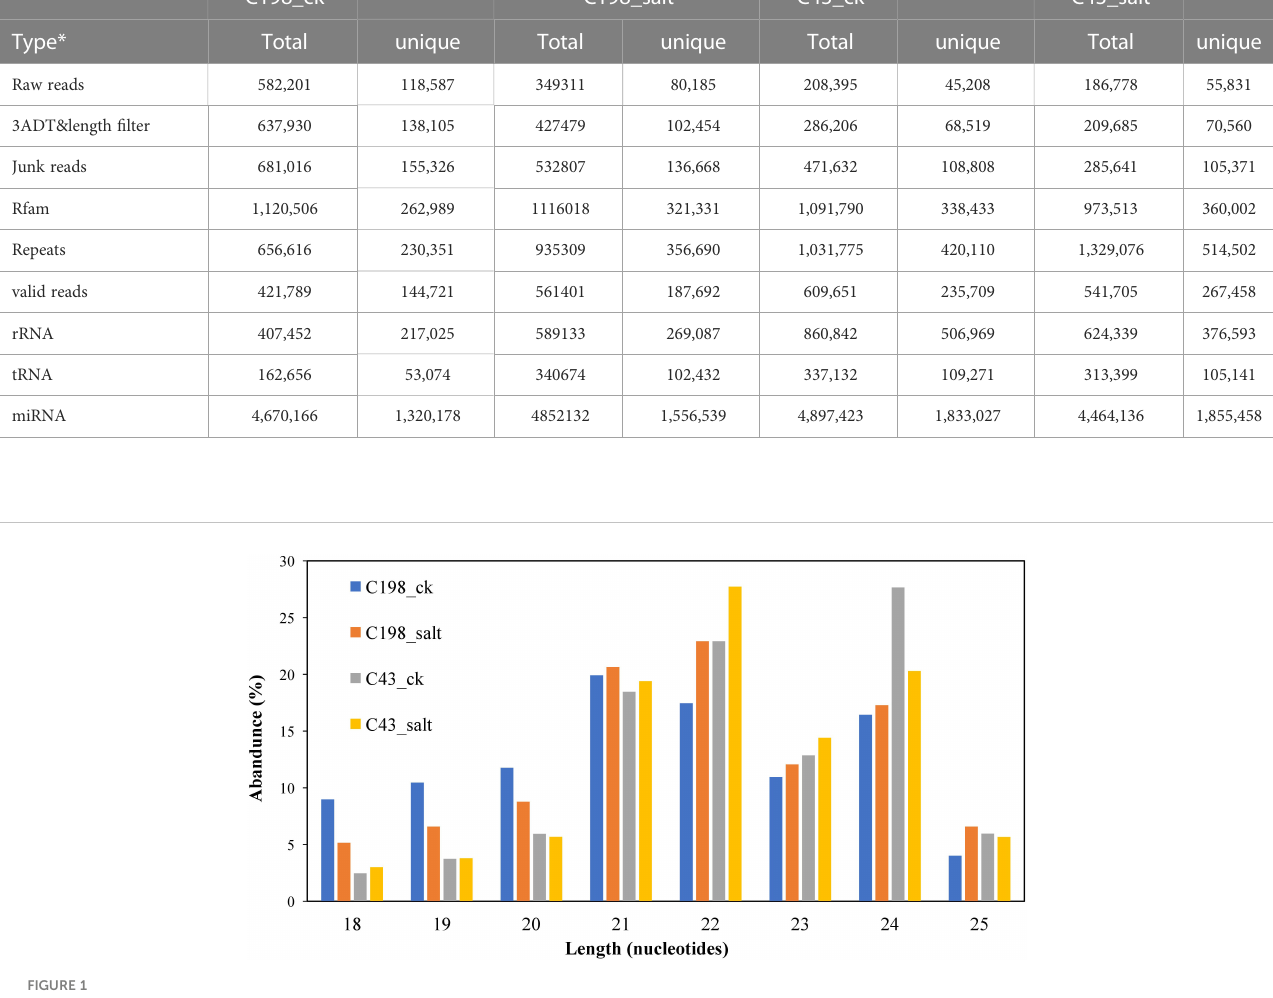
FIGURE 1 Length distribution of unique sequences after